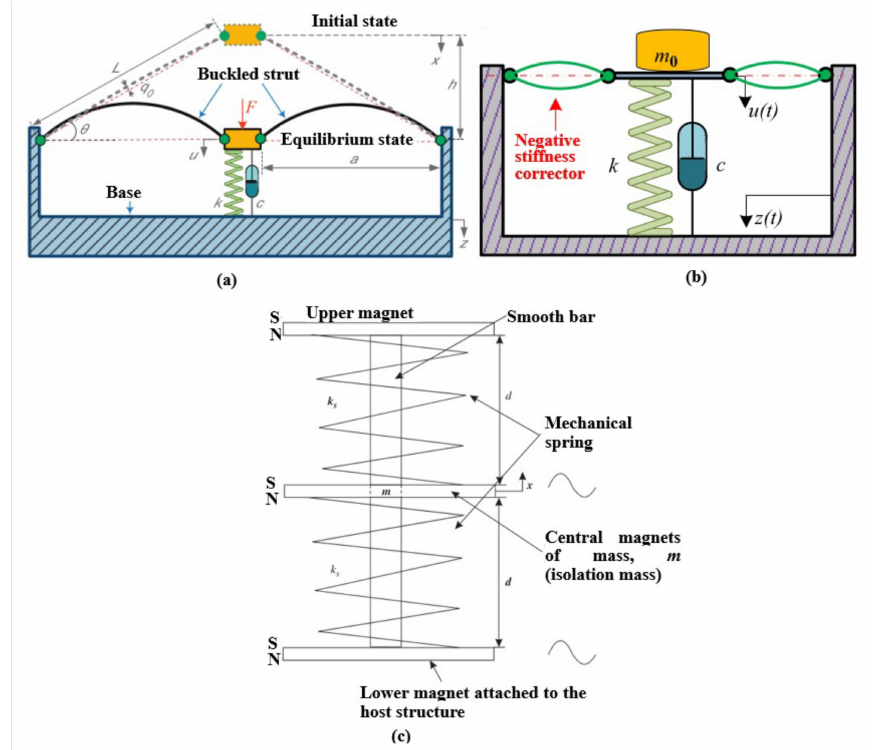
Figure 7. Classical structures with positive and negative stiffness in ( a ) QZS isolator structure of euler buckling beam, ( b ) Double Euler Buckling Beam Symmetrical Distribution QZS Vibration Isolator and ( c ) QZS magnetic spring structure.Reprinted/adapted with permission from Ref. [69].